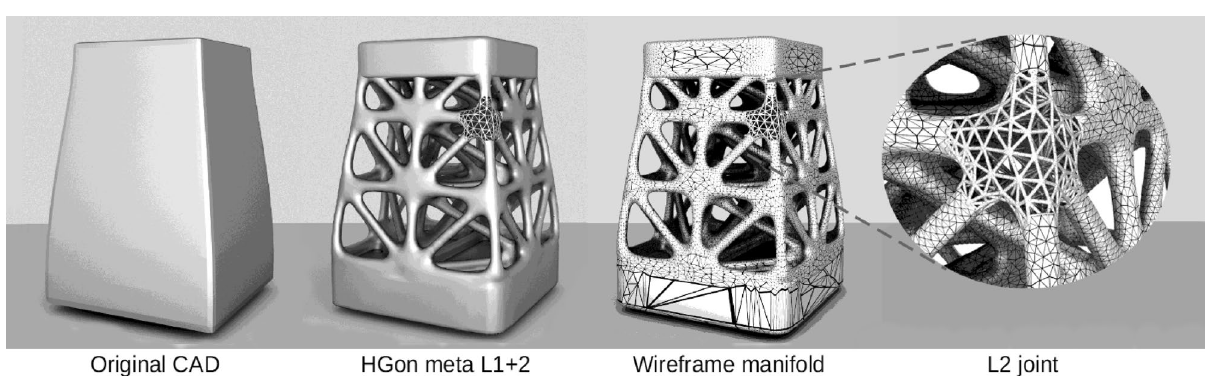
Figure 2. A simple example HGon Level 1 + 2 meta-structure computed from a CAD model (vibration damping platform support). The closeup (L2 joint) further illustrates the meta-structure concept. By varying L1 and L2 densities and topologies the overall structure can be ‘tuned’ to damp desired vibration spectra. Meta- structure generation and volumetrics are programmed in Python (http:// python. org) and CuPy (http:// cupy. dev) with 3D visualization using Blender3D (http:// blend er. org).